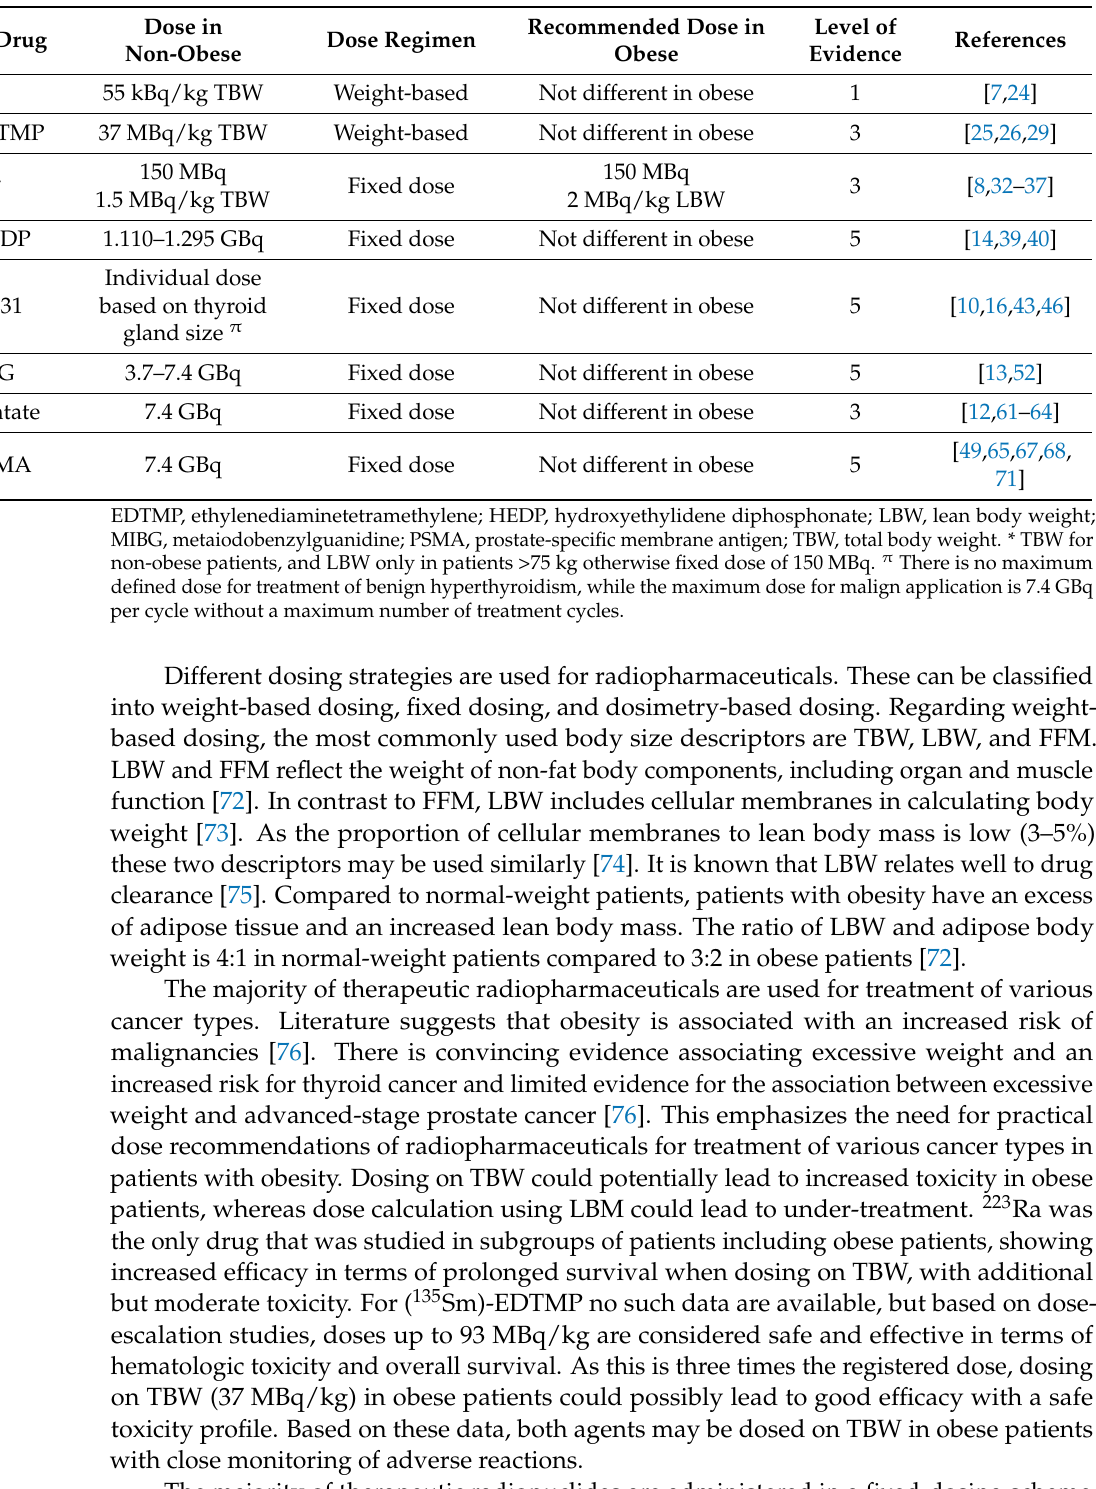
Table 2. Overview of dosing regimens of radiopharmaceuticals and recommendations for dosing in obese